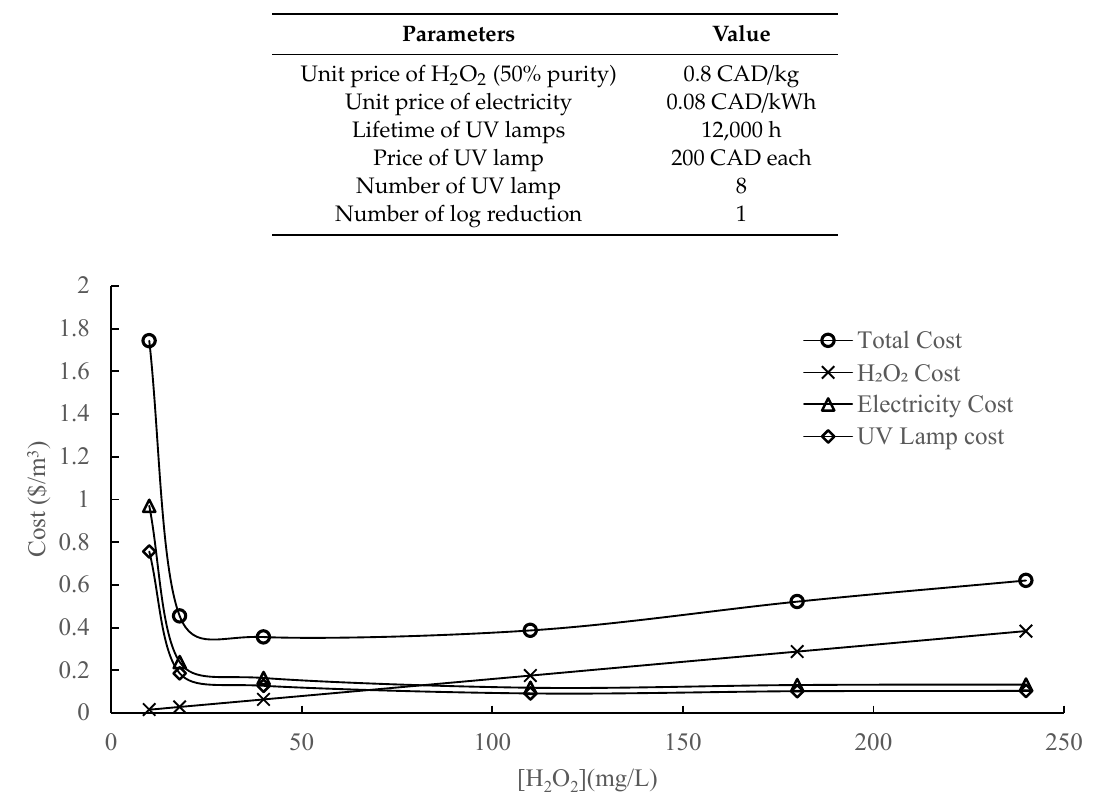
Table 4. Parameter estimation for cost calculation.